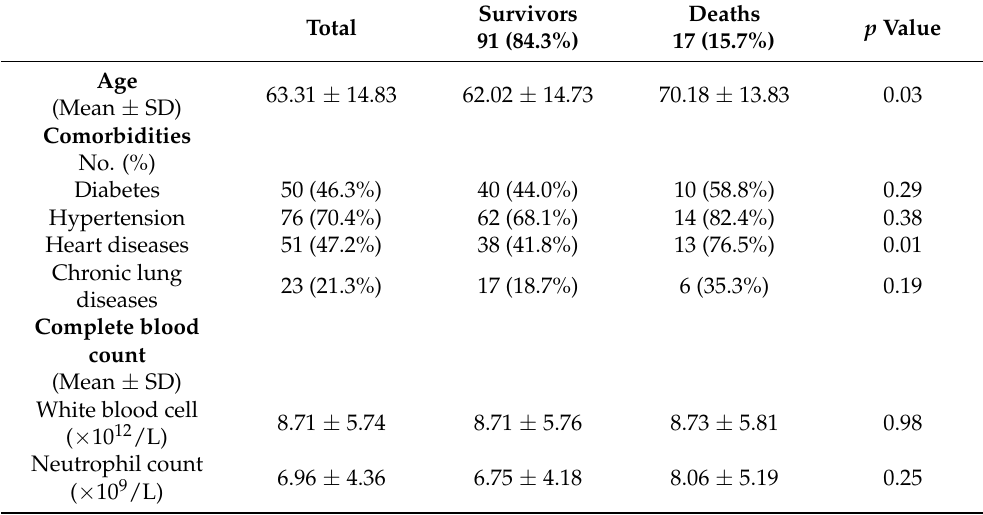
Table 1. Baseline characteristics and laboratory test results in 108 hospitalized patients with